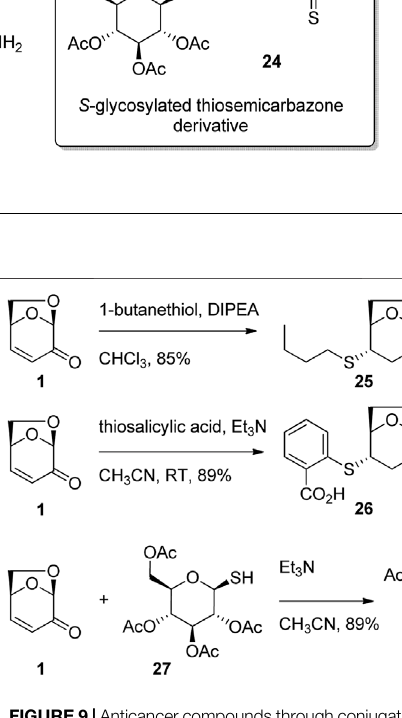
FIGURE 9 | Anticancer compounds through conjugate addition of thiols to